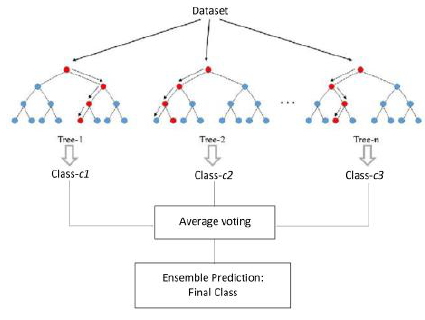
Figure 4 . Classification concept based on RF